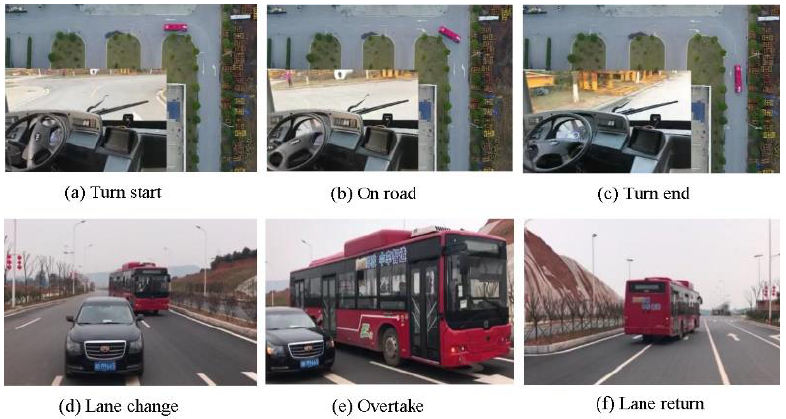
Figure 16. Several pictures of field test.